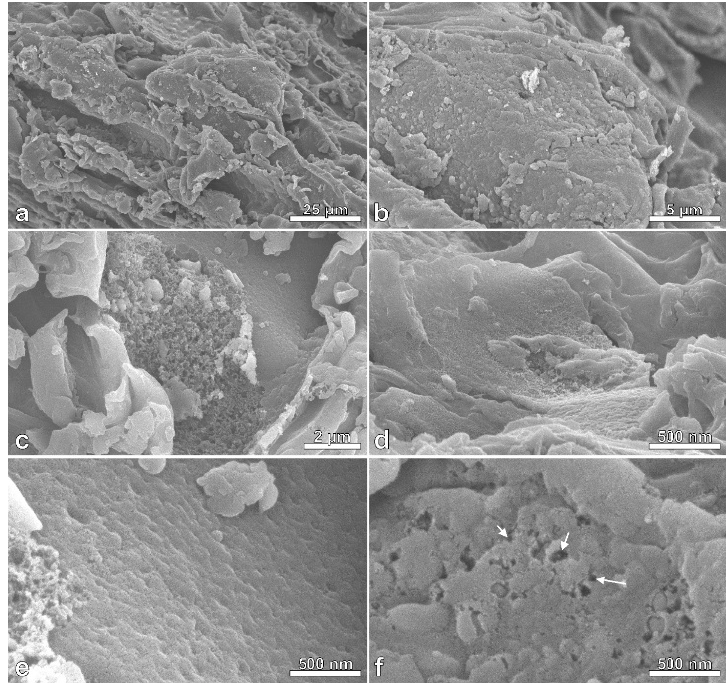
Figure 3. Field emission scanning electron photomicrographs (FESEM) of activated carbon (AC) produced from the charcoal of massaranduba ( Manilkara huberi ) sawdust, showing the particle surfaces ( a – f ). Note the porosity that was developed and visible at virtually all magnifications shown, and the appearance of nanoscale pores ( f , arrows).